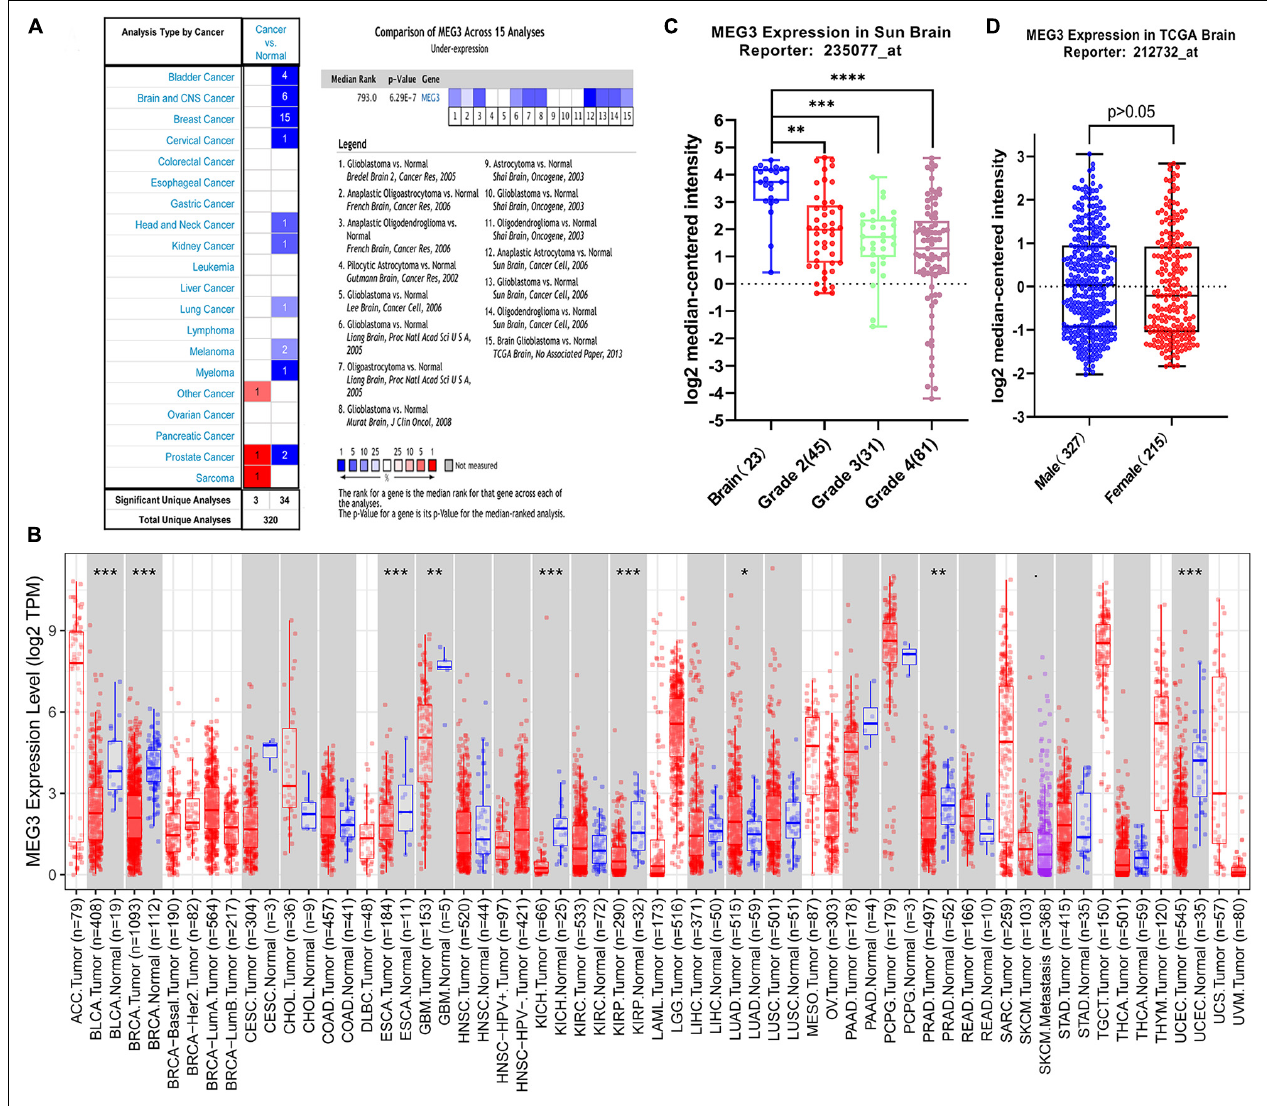
FIGURE 1 | (A) MEG3 expression levels in different types of human cancers compared with normal tissues in the Oncomine database. (B) Human MEG3 expression levels in different tumor types from TCGA database were determined by TIMER (* P < 0.05, ** P < 0.01, *** P < 0.001, **** P < 0.0001). (C) The expression of MEG3 decreased with increase of grade. (D) Comparison of the expression level of MEG3 in male and